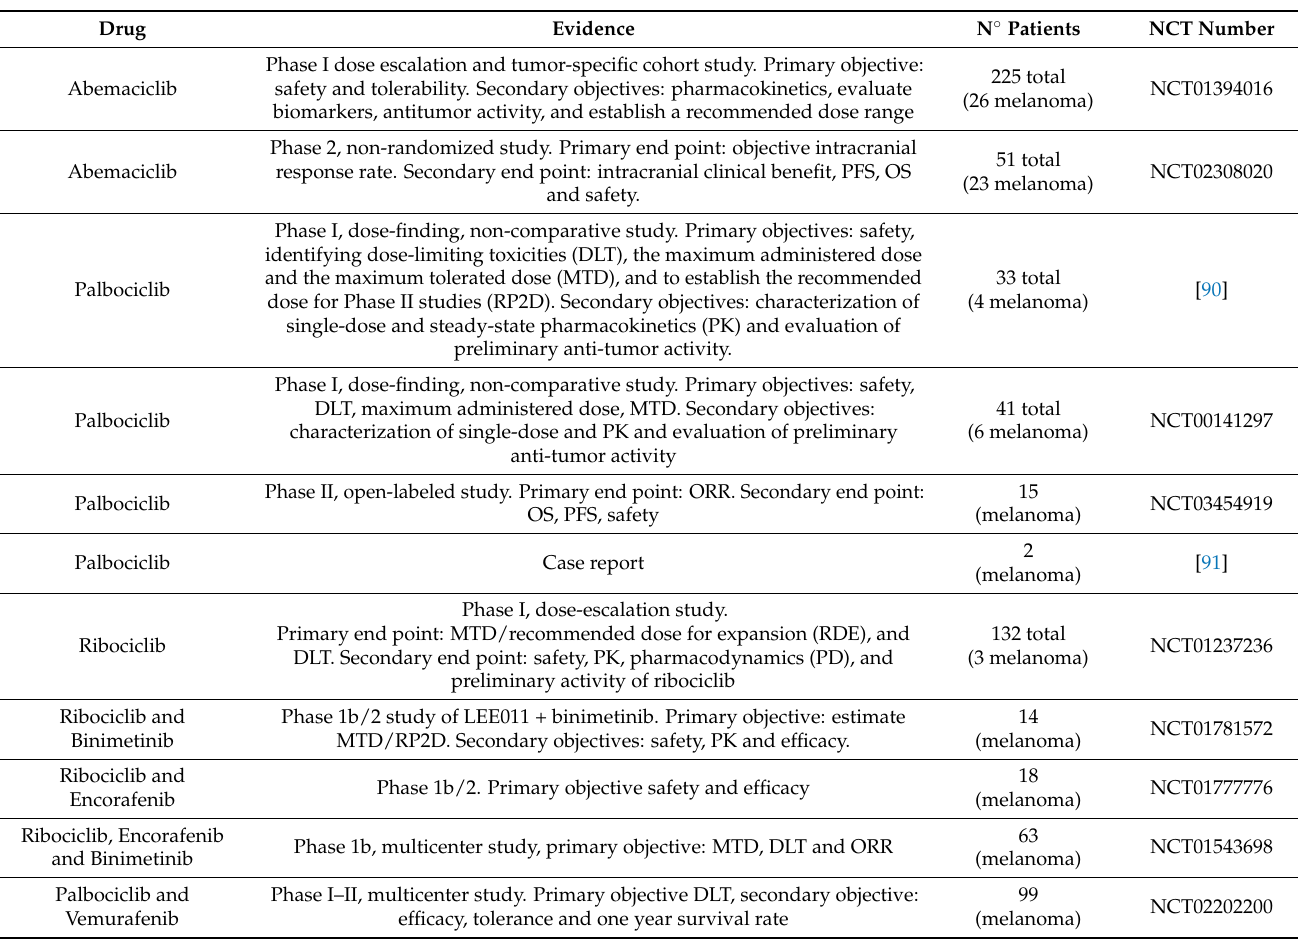
Table 2. Clinical evidence of CDK4/k inhibitors in